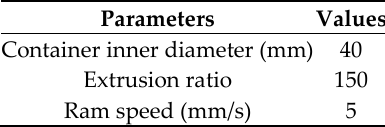
Table 2. Billet material property and processing parameters in extrusion